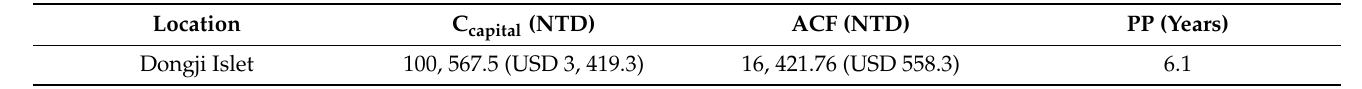
Table 12. Estimated payback